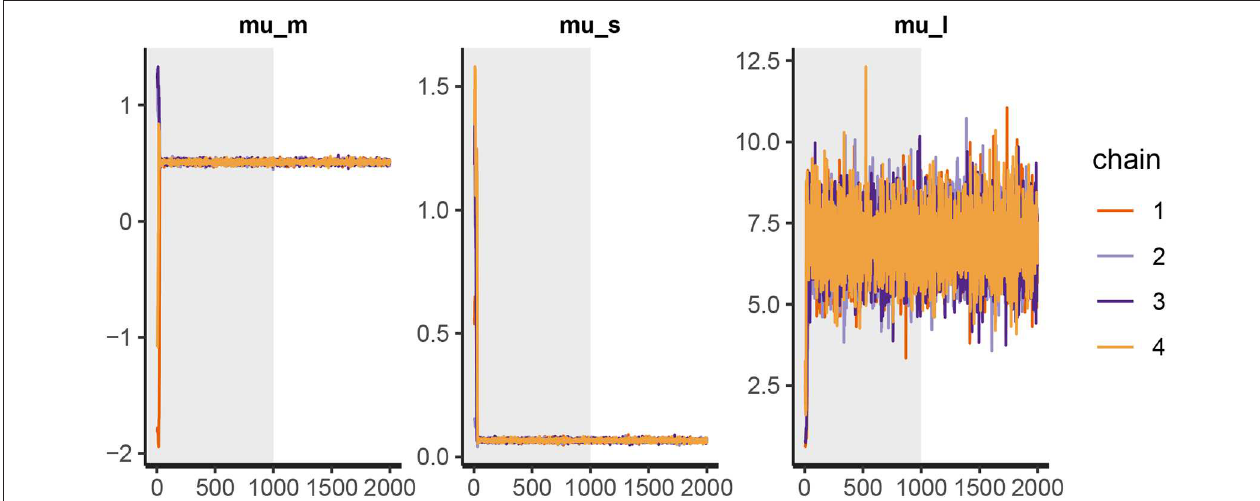
FIGURE 6 | The trace plot for rt_control_fit . The traceplot gives us no cause for concern regarding MCMC convergence and mixing. The trace plot for rt_test_fit is similar. Note that the first 1,000 iterations (shaded gray) are used for warmup (tuning of the MCMC algorithm) and are discarded. The next 1,000 iterations are used for sampling. Informally speaking, if trace plots after the warmup period look like “hairy caterpillars” there is no reason for concern.